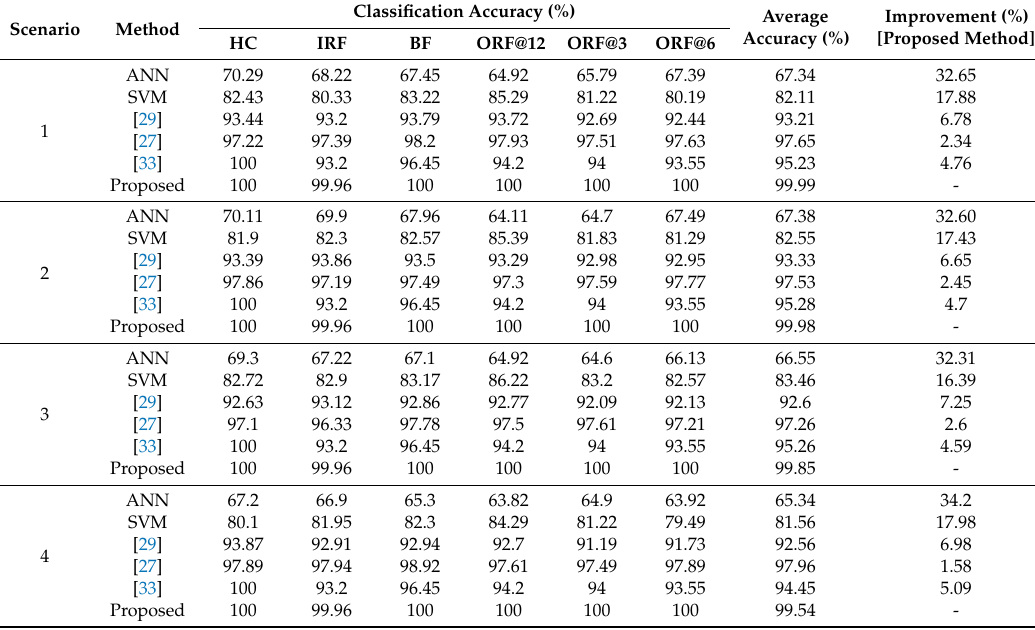
Table 7. Comparison of classification accuracy (proposed vs. existing